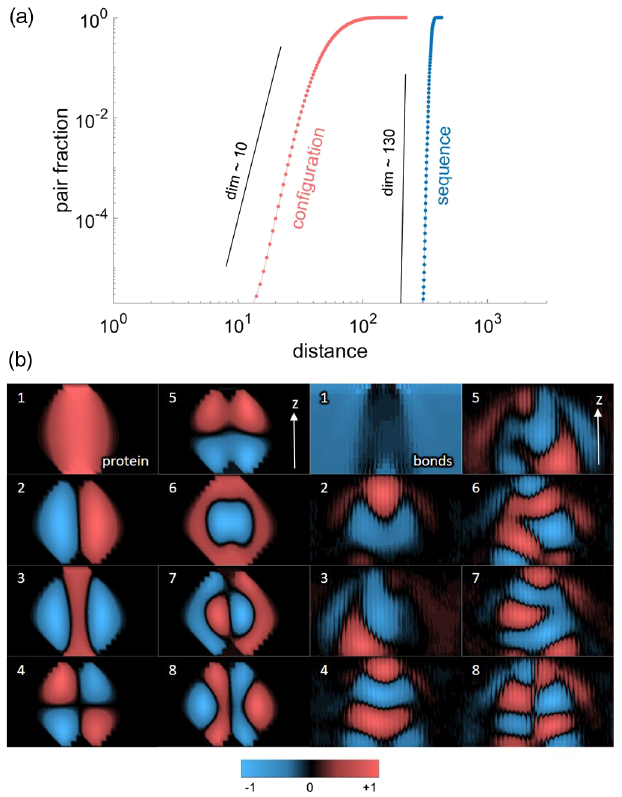
FIG. 11. The AA interaction model. (a) Dimensions of the genotype and phenotype spaces are similar to the standard model (Fig. 3). (b) Left: The first few eigenfunctions for the configu- ration. Right: The same for the bond